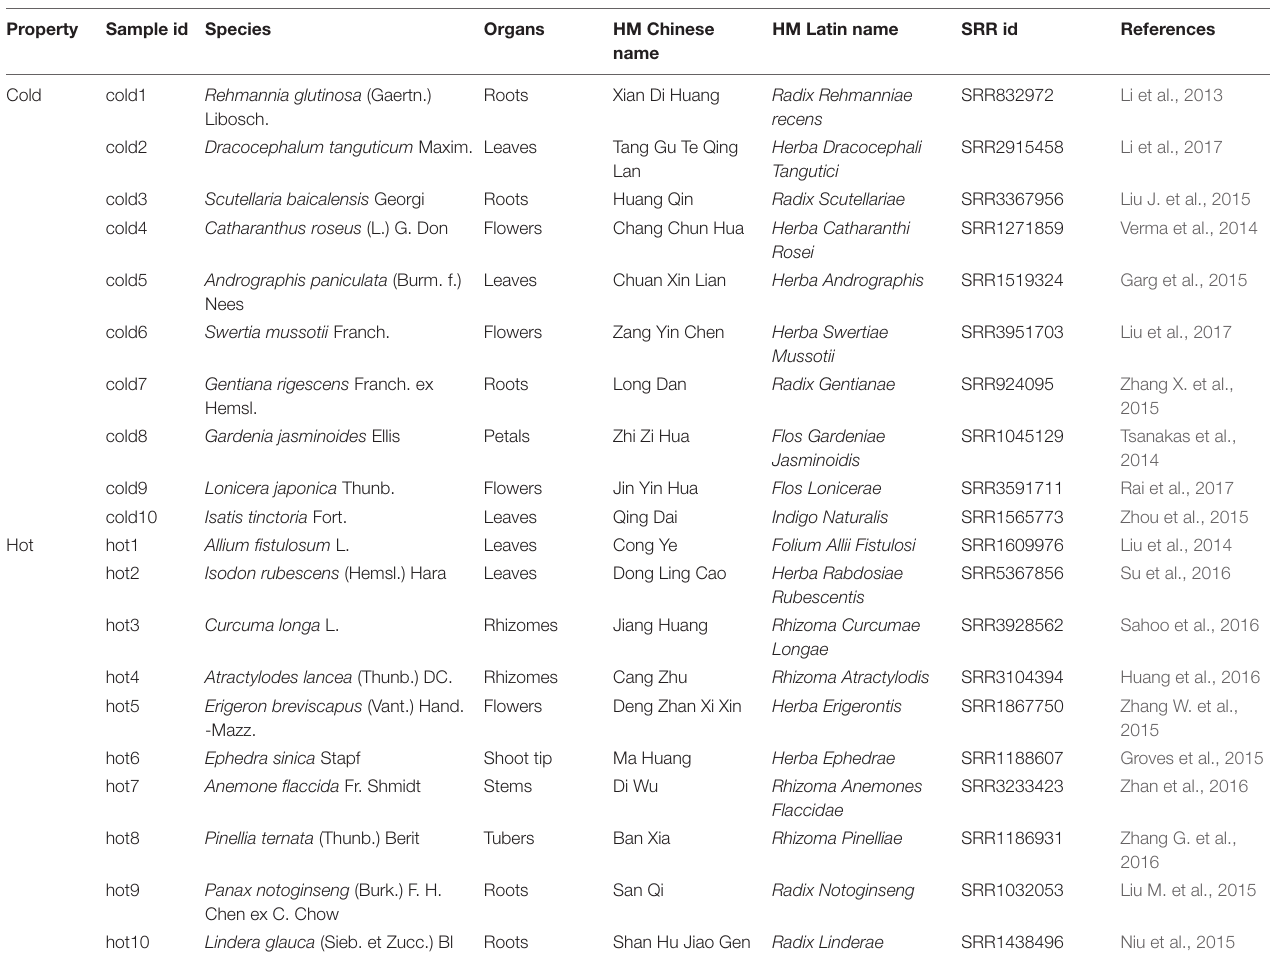
TABLE 1 | Selected Chinese herbal medicines. Property Sample id